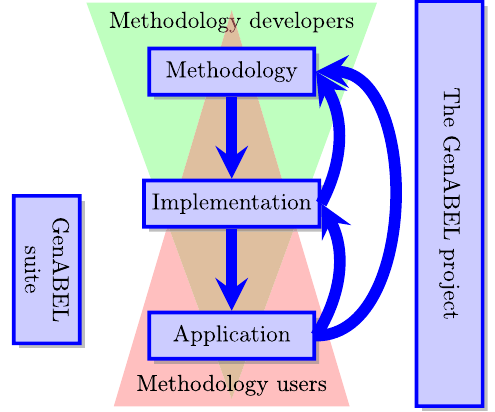
Figure 1. The structure of the GenABEL project and the information flow within it.